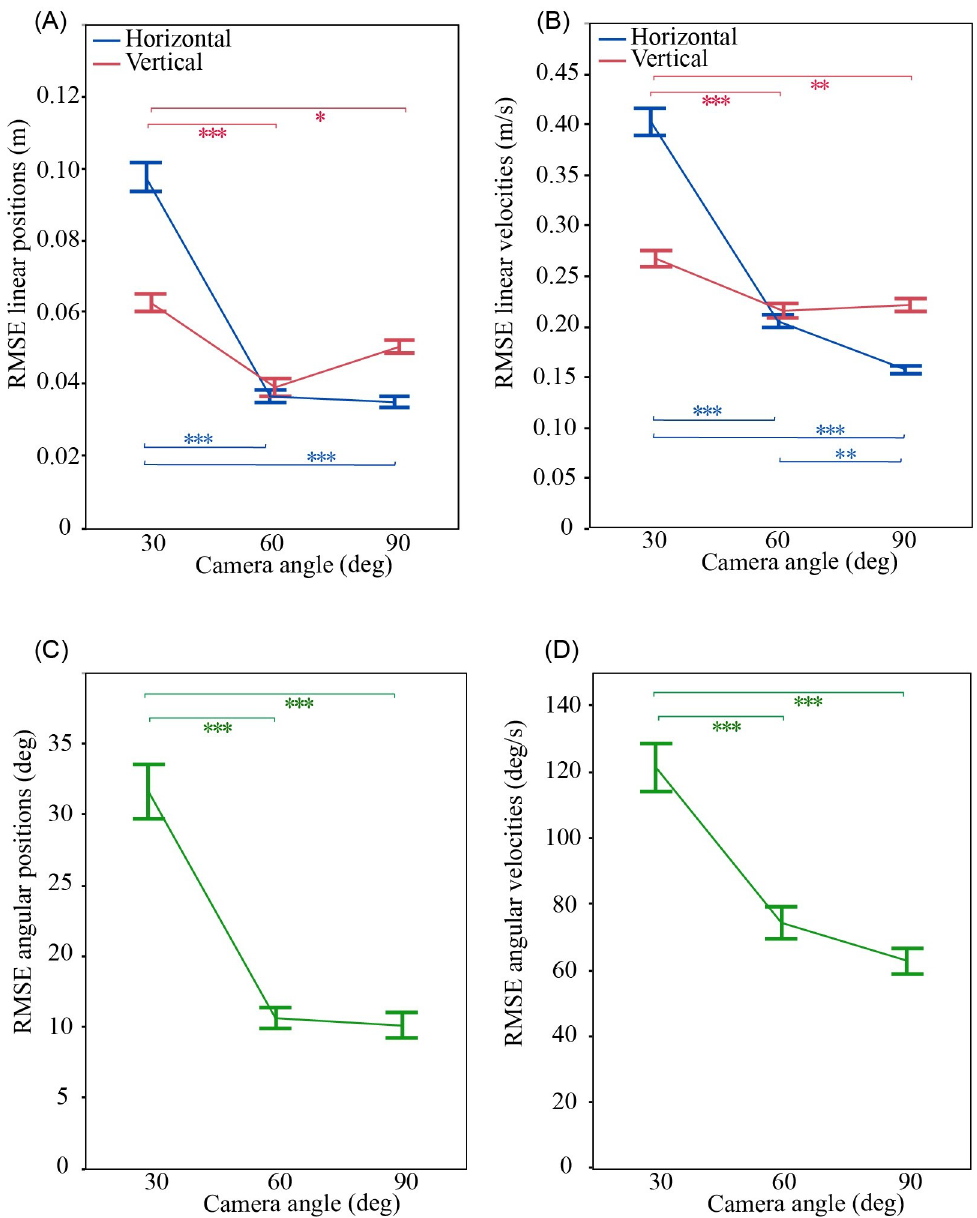
Fig 8. Effect of camera angle on the accuracy of Kinovea estimates. (A) Linear position, (B) linear velocity, (C) angular position, and (D) angular velocity. Root mean square errors (RMSE) are from comparison between Qualisys ground truth signals and Kinovea estimates based on the calibration frame located in the plane of the fall, and filtering of position data with a 10 Hz cut-off frequency. Data points show mean values, and error bars show ± 1 SE. � p � 0.05, �� p � 0.01, ��� p �